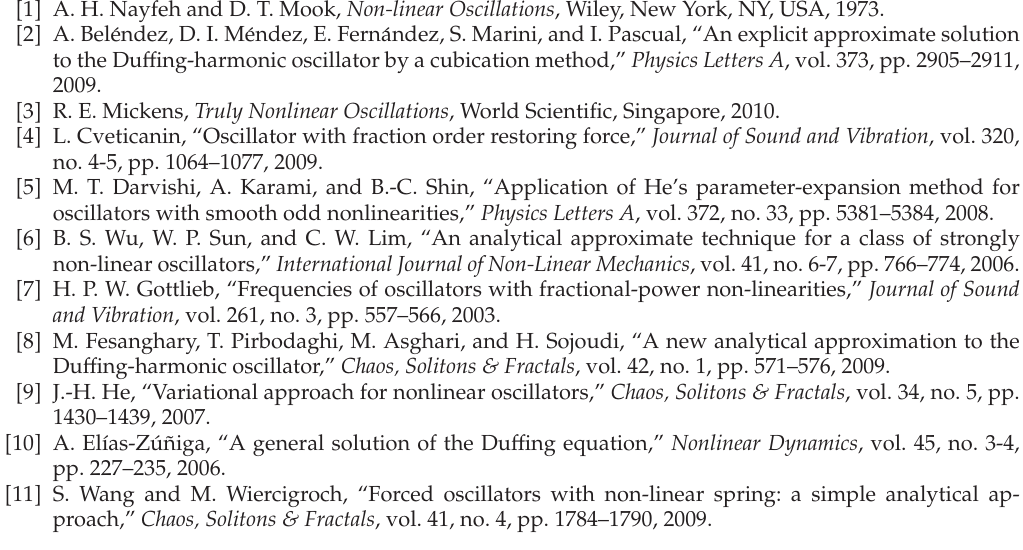
the frequency for free vibration and to find the response for forced vibration. The proposed method is geometrically explained by means of the first and second averaged derivatives of the restoring force. Various examples show that the solution can be approximated simply and accurately, no matter how complex the restoring force function